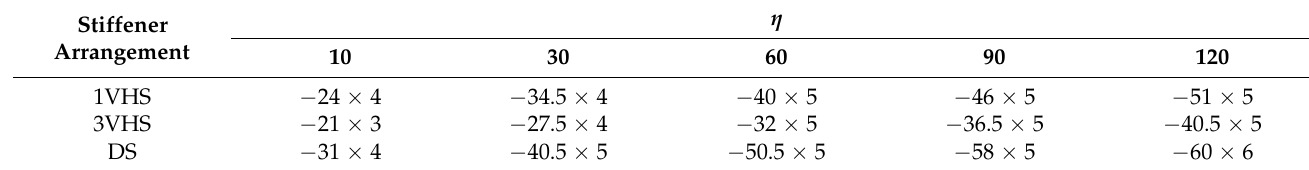
Figure 4. Boundary conditions and loading location. Table 2. Dimensions of the stiffeners